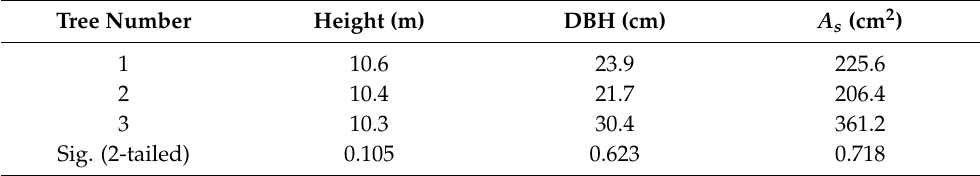
Table 1. Summary of biological parameters for the three selected Populus euphratica trees. Tree Number Height (m) DBH (cm) A s (cm 2 ) 1 10.6 23.9 225.6 2 10.4 21.7 206.4 3 10.3 30.4 361.2 Sig. (2-tailed) 0.105 0.623